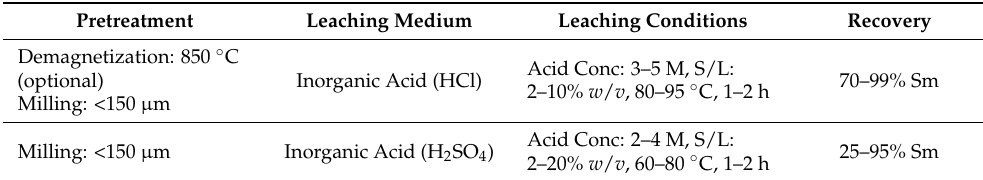
Table 7. Summary of the studied leaching conditions for the recovery of Sm from SmCo permanent magnets